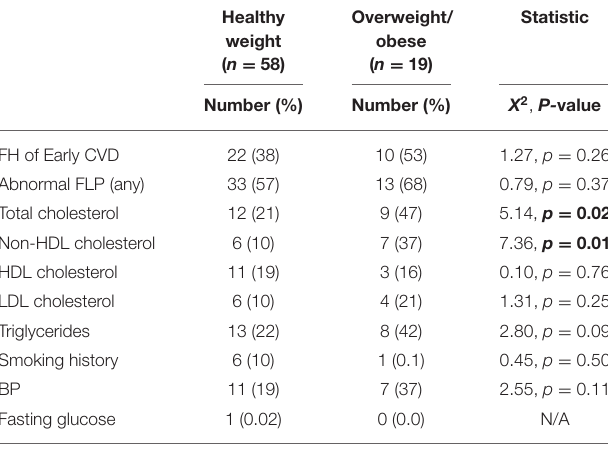
TABLE 3 | CVD risk factors among healthy-weight vs. overweight/obese children and adolescents with MDD.